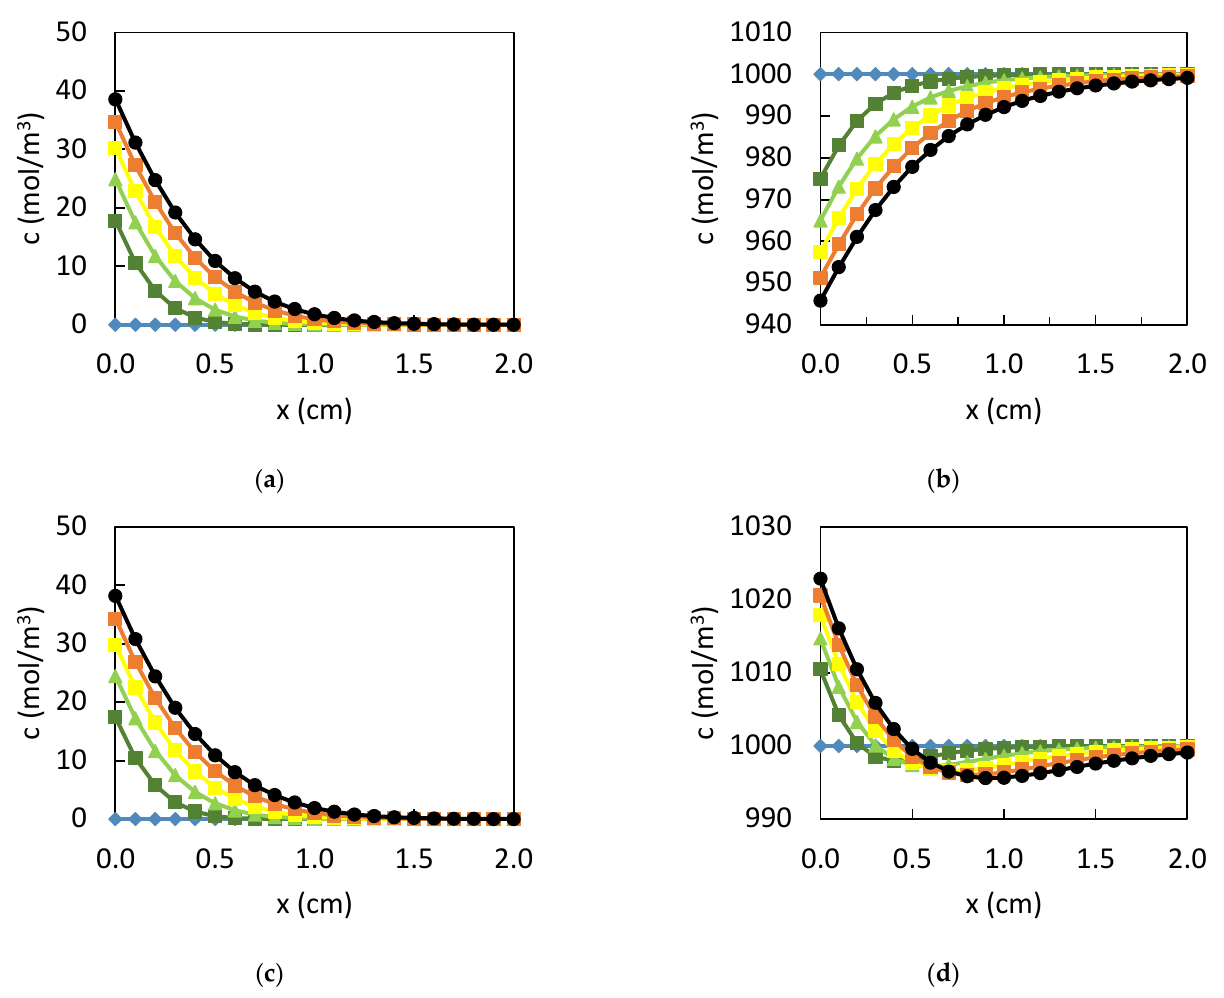
Figure 6. Evolution of the ion concentration in an electrolyte of 1000 mol/m 3 HCl and of size L = 10 cm with only the first 2 cm are presented for six times t = 0 s (light blue), 3600 s (dark green) 7200 s (green), 10,800 s (yellow), 14,400 s (orange), and 18,000 s (black). ( a ) Pb 2+ ions, ( b ) H + ions, ( c ) H 2 and ( d ) Cl −